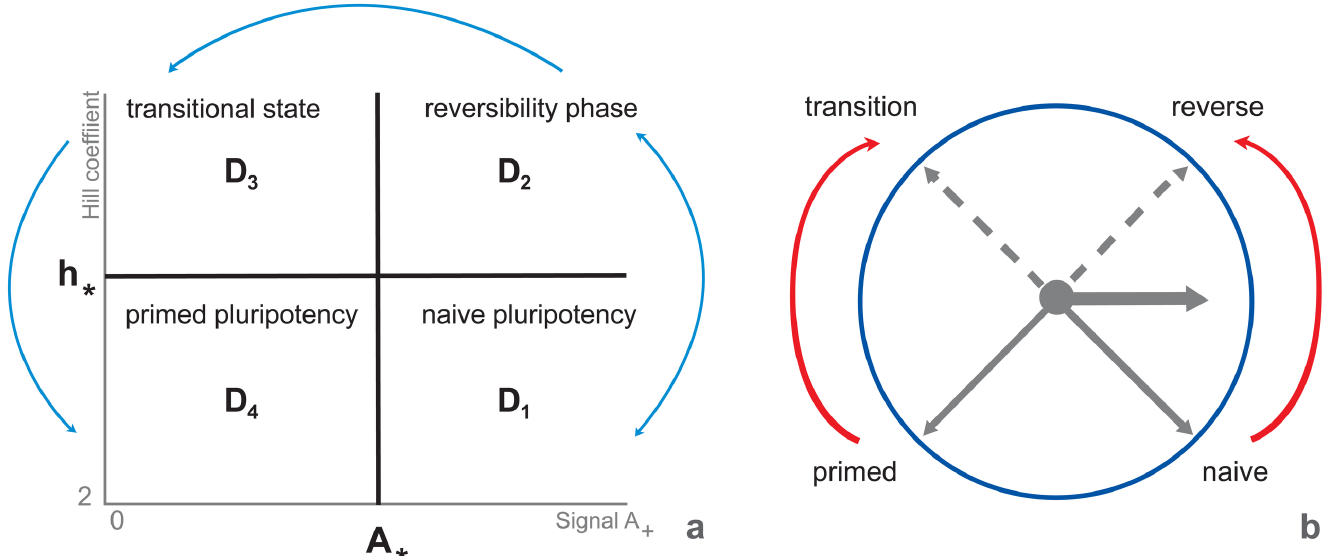
Fig 3. Multiplicity and stability of stationary solutions depending on parameters A and h . D 4 domain comprises a single stable steady state, pluripotency; D 2 domain encompasses a single unstable state (oscillation). D 3 domain includes three unstable states (oscillations); D 4 domain contains three states, from which two (pluripotency and differentiation) are stable and one (transition between these states is unstable (according to Fig 2A). Domains (a) predicted by the model and (b) their correspondence to developmental progression of ESCs from the na ï ve pluripotency (the ground state) to lineage commitment according to [61]. The initial phase of exit from the ground state is asynchronous in the cell population and reversible until the complete dissipation of na ï ve state factors (reviewed in [59, 61, 62]). Cells reaching a transitional point after 2i withdrawal are competent for lineage specification and characterized by the absence of both groups, na ï ve factors and lineage markers. The late phase of pluripotency (primed pluripotency) is characterized by nascent expression of lineage specification factors. The “clock model” was proposed as a route of consistent transitions with the dual mechanism of hour hand movement depending on the initial cell state: pluripotent (counter-clockwise movement of black solid arrows) or differentiated (clockwise movement of black solid arrows). Red arrows, in turn, reflects directions from na ï ve to reverse- transition-primed stages (developmental progression during differentiation) or from primed to transition-reverse-na ï ve states (developmental progression during reprogramming into pluripotent state), while dotted black arrows were added to underline intermediate reverse and transitional states to which domains D correspond,